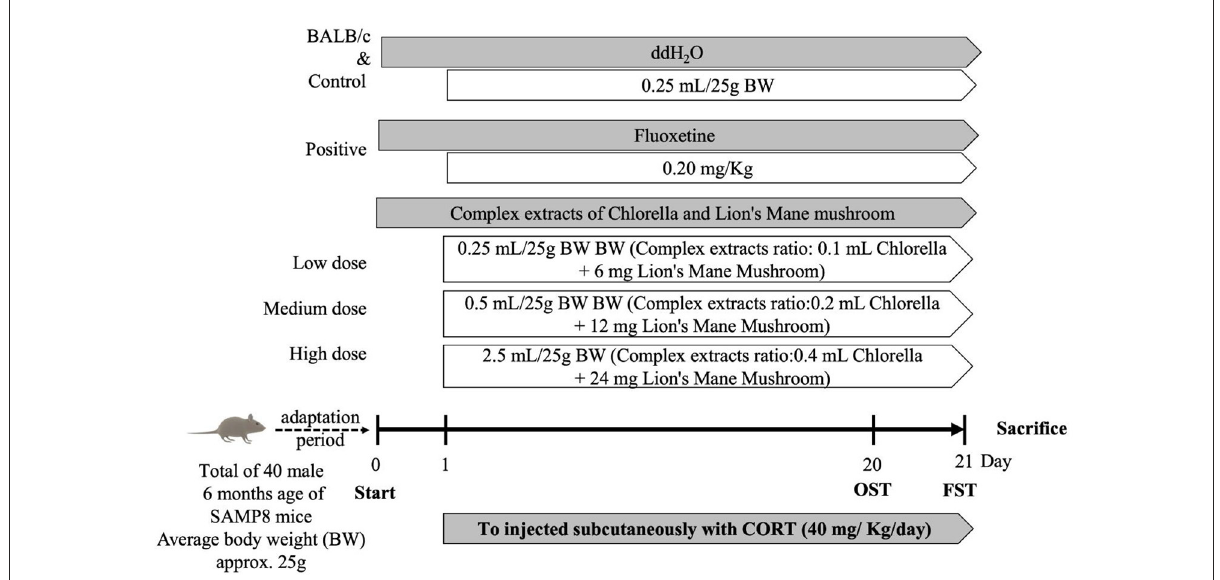
FIGURE1 Schedule of animal experiments. Random subgroup adaptation for 7 days followed by treatment of mice with combined extracts, Fluoxetine, or water for 21 consecutive days, respectively. All mice were exposed to the CORT procedure for 21 days. Behavioral tests were performed on all